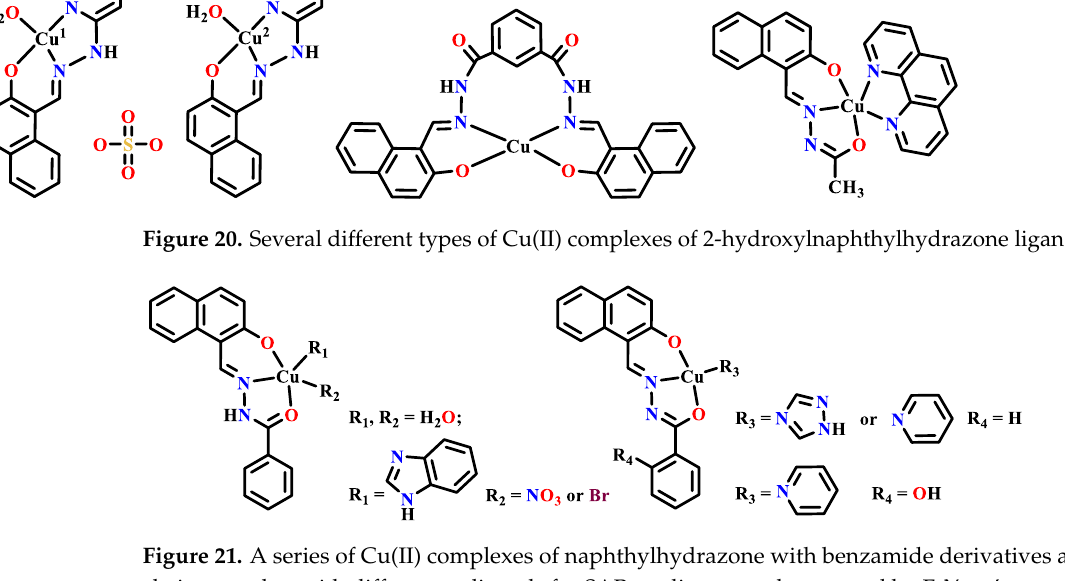
Figure 21. A series of Cu(II) complexes of naphthylhydrazone with benzamide derivatives as side chains together with different co-ligands for SAR studies, recently reported by F. Yang’s group.